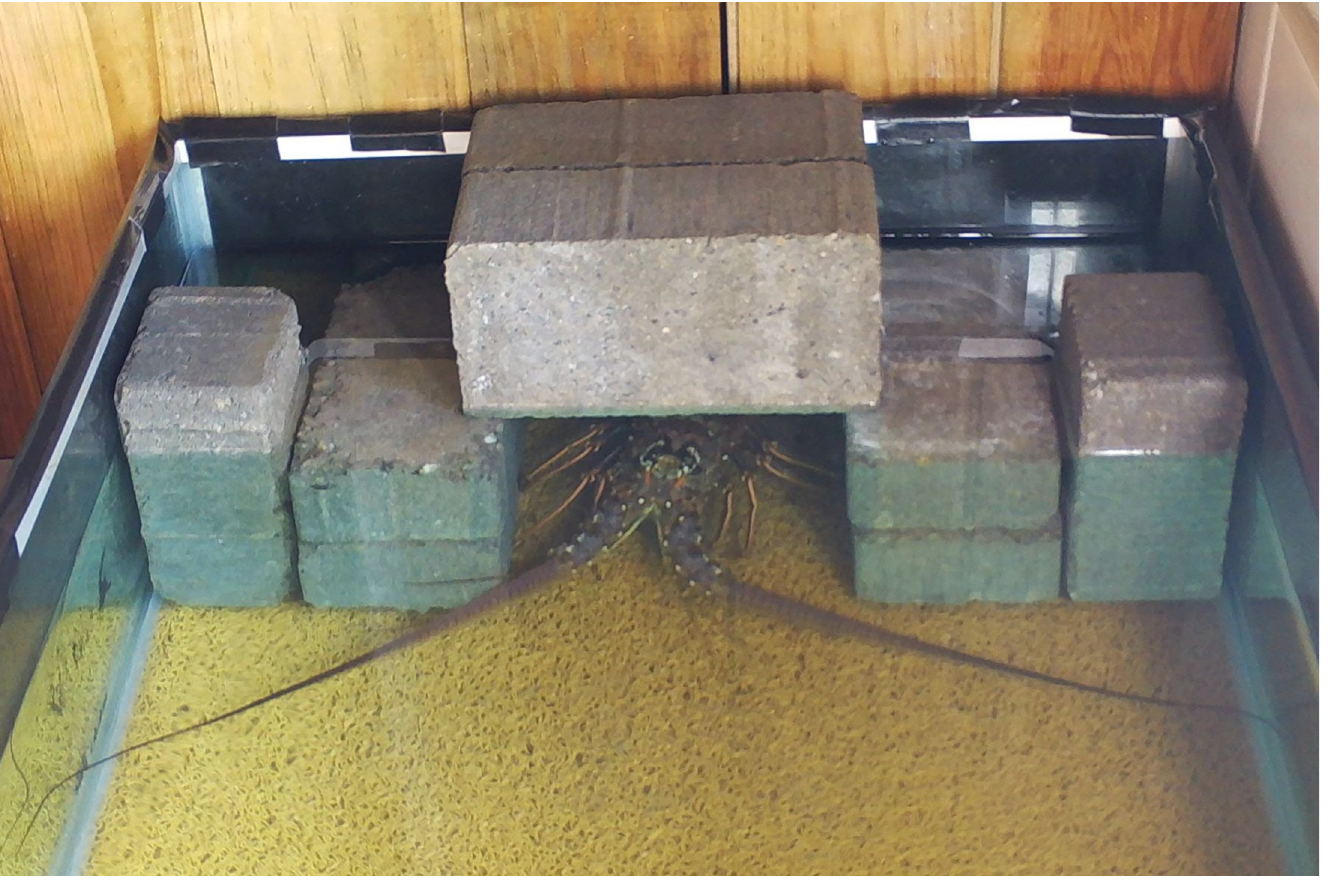
Fig 2. Lobster inside the shelter in the trial